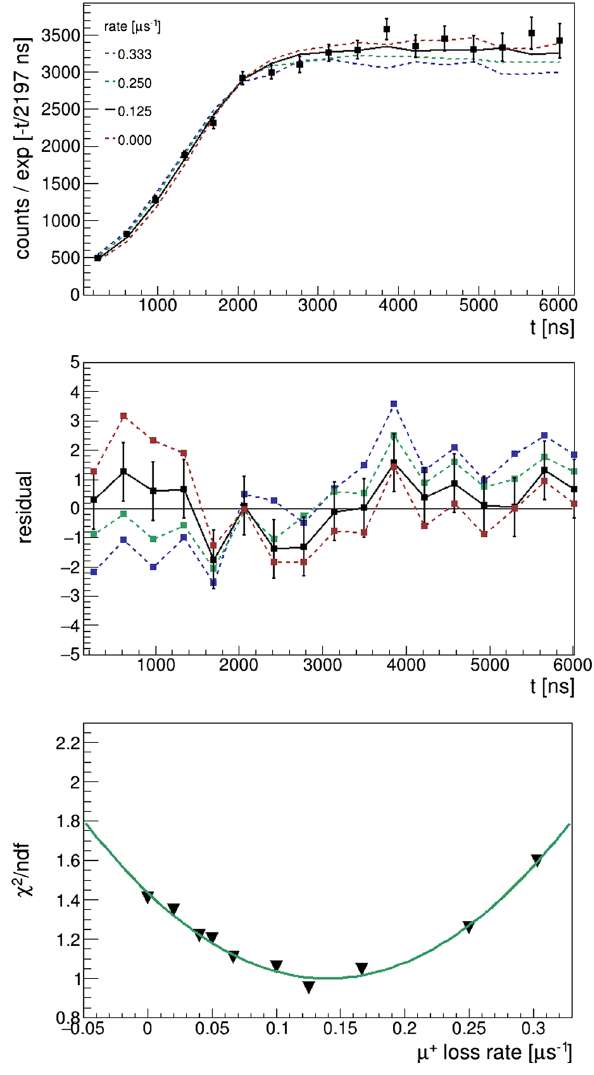
Fig. 8 (Top) Simulated time spectra for effective loss rates of R = ( 0 , 0 . 125 , 0 . 25 , 0 . 333 ) µ s − 1 (curves). The − 500 V measurement is represented by square points. The data and the simulations have been corrected for the finite muon lifetime by multiplying the counts by e t / 2197 ns . (Middle) Residuals for the time spectra from the top figure. For simplicity, error bars are shown only for the curve with reduced χ 2 = 0 . 95. For other curves error bars are of similar size. (Bottom) Reduced χ 2 as a function of the effective loss rate R . A second-order polynomial was fitted to these points (green